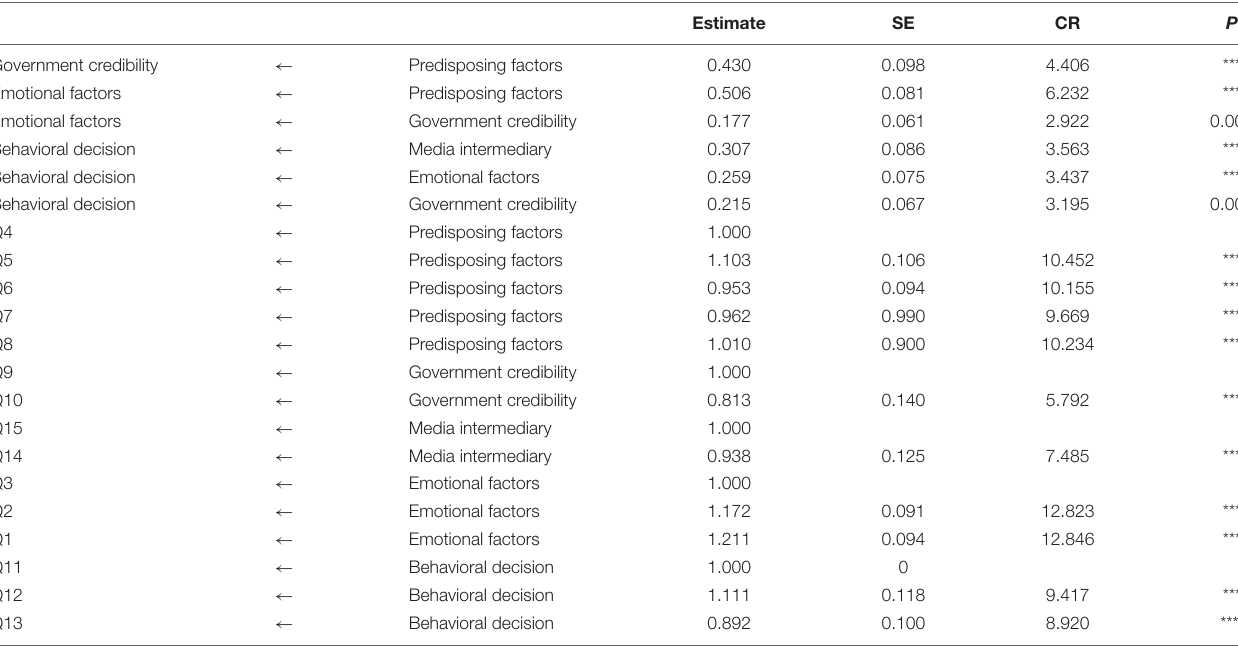
TABLE 5 | Corrected coefficient estimates and parameter